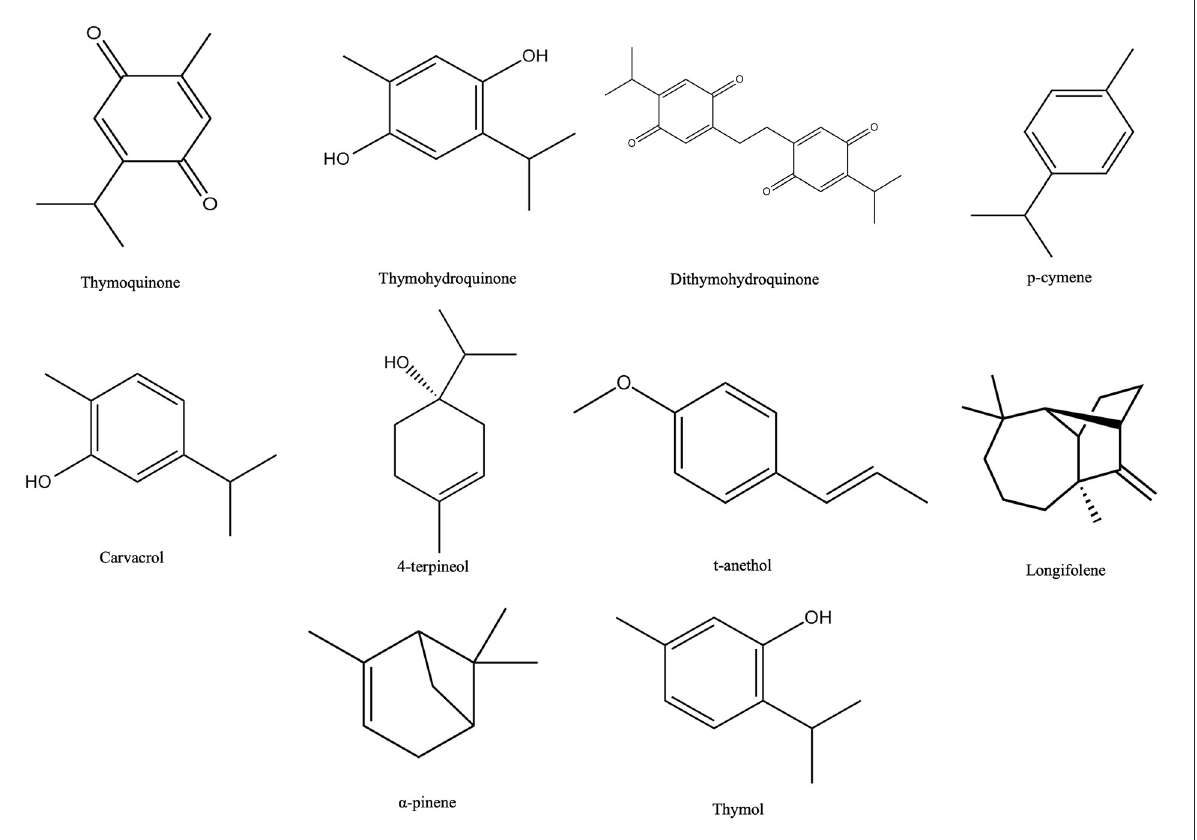
FIGURE2 Chemical structures of major phytochemical compounds in